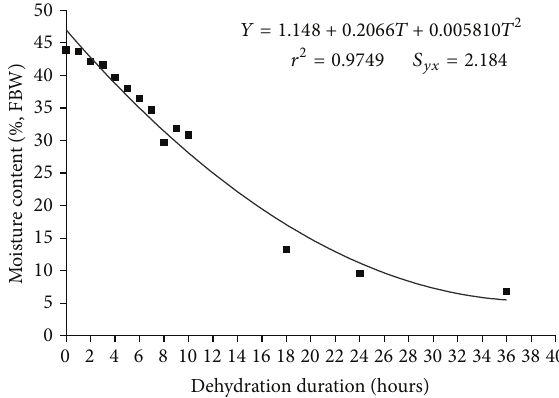
Figure 2: Desiccation curve for Genipa americana L. seeds. Initial moisture content of seeds was 43.89%. Moisture content data were subjected to second-order polynomial regression using GraphPad Prism statistical software package.